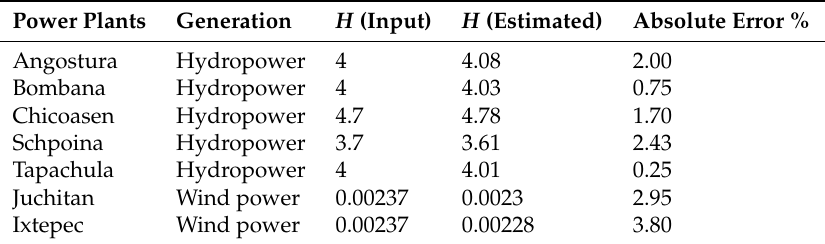
Table 5. Inertia estimation results, load increment